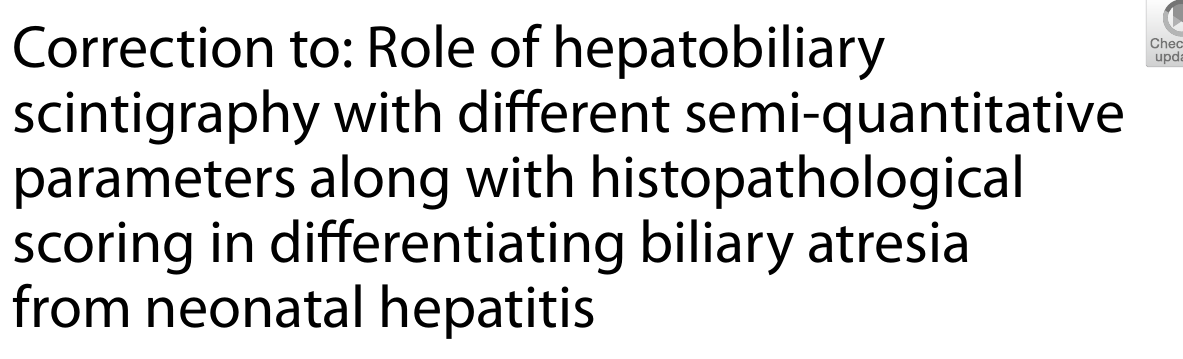
Fig. 6 Association between semi-quantitative param- eters and